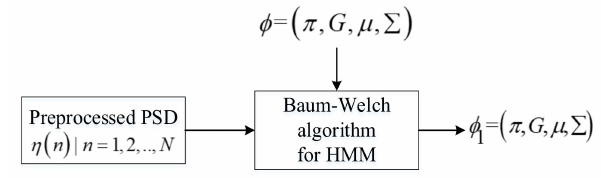
Figure 4. Schematic of HMM